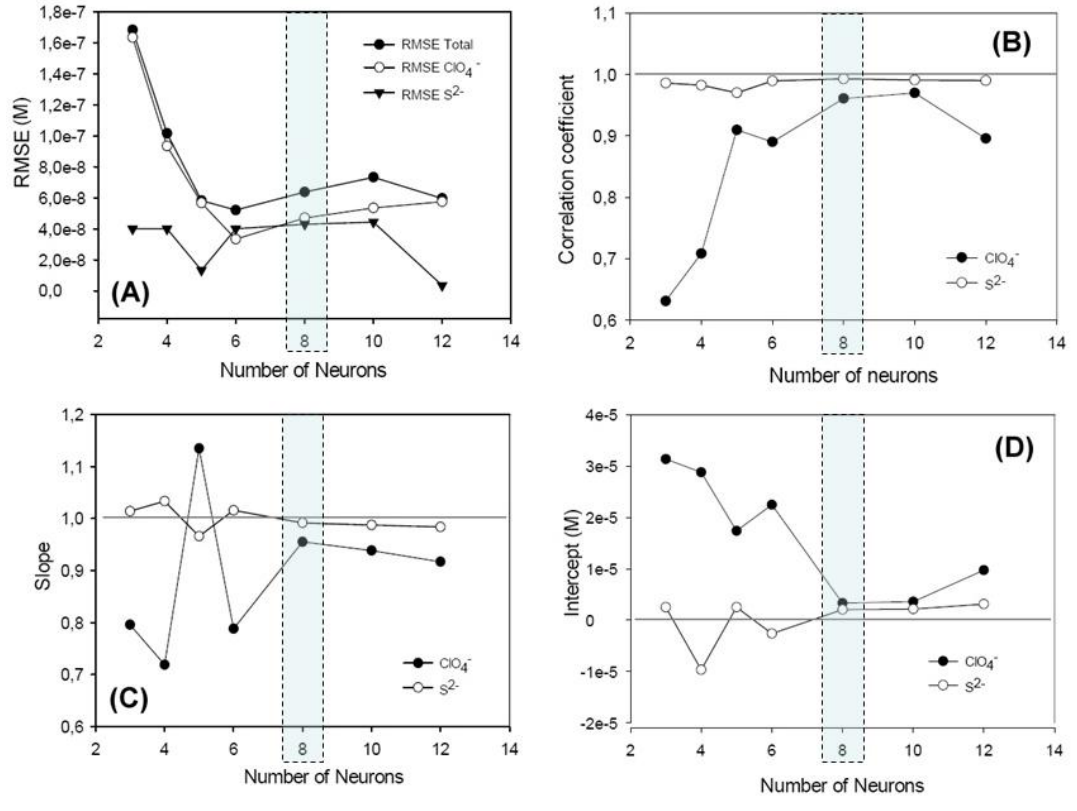
Figure 3. Selection of the optimal number of neurons in the hidden layer for the ANN model using tansig and purelin transfer functions for hidden and output layer respectively. (A) RMSE values, (B) correlation coefficients, (C) obtained slopes and (D) intercepts for the comparison regression between obtained vs. expected